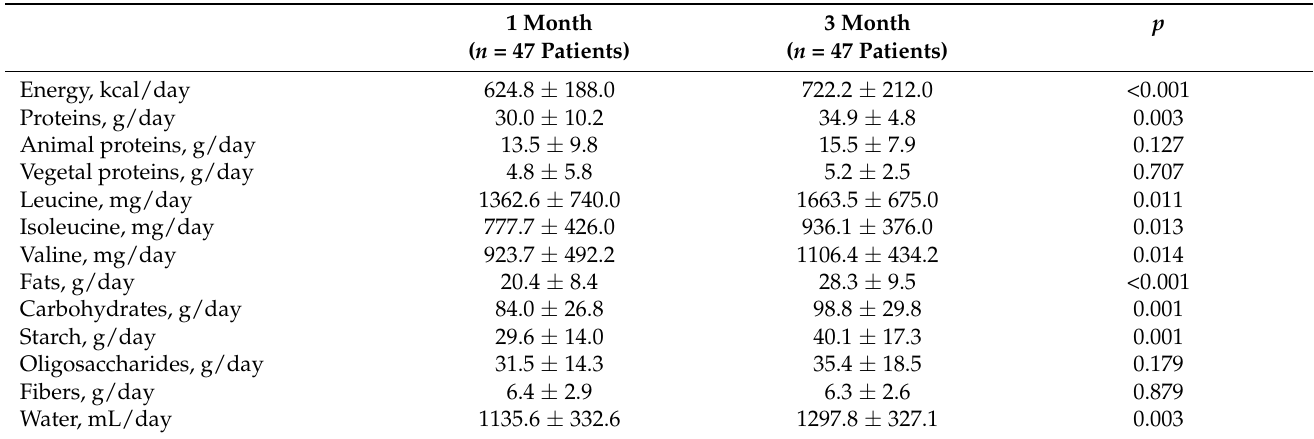
Table 2. Composition of the natural diet at 1 month and 3 months after SG.